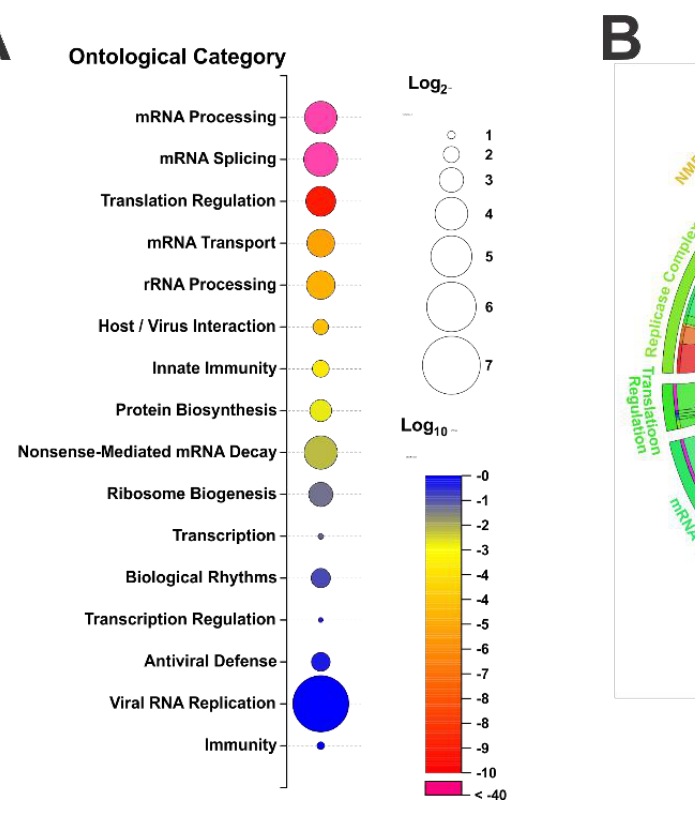
Figure 3. Ontological Analysis of RNA-Binding Proteins Implicated as Alphavirus Interactants. ( A ) The 125 host proteins identified as RNA-binding proteins via analysis of molecular function were assessed using DAVID to determine enriched biological processes. Shown is an enrichment plot of the top statistically enriched categories. Circle size is indicative of enrichment (relative to expected) and color indicates statistical significance (as per Bonferroni adjusted p-Values). ( B ) A chord plot of the top nine statistically enriched ontological biological processes, and the viral components with which the constituent interactants were associated. The category labeled P is abbreviated from Protein Biosynthesis.